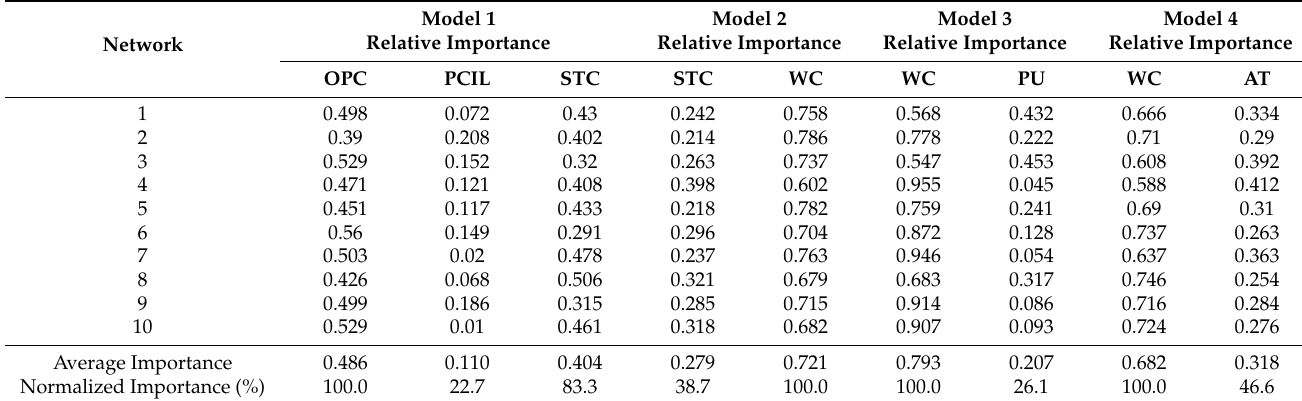
Table 11. Neural network sensitivity analysis.